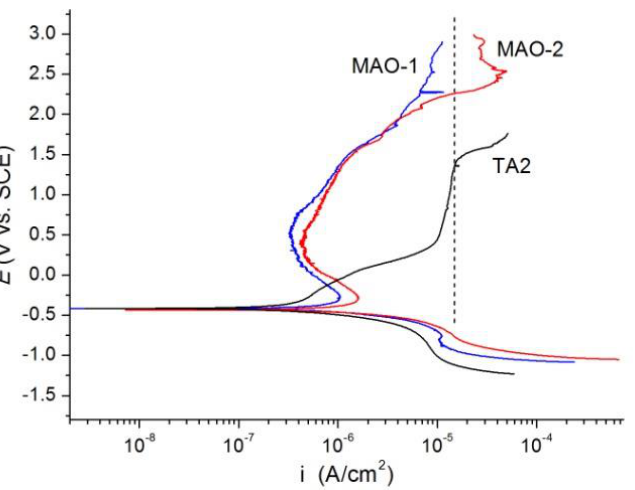
Figure 12. Potentiodynamic polarization curves of MAO-1, MAO-2, and bare TA2 specimens after 9 days immersion in 3.5% NaCl solution.